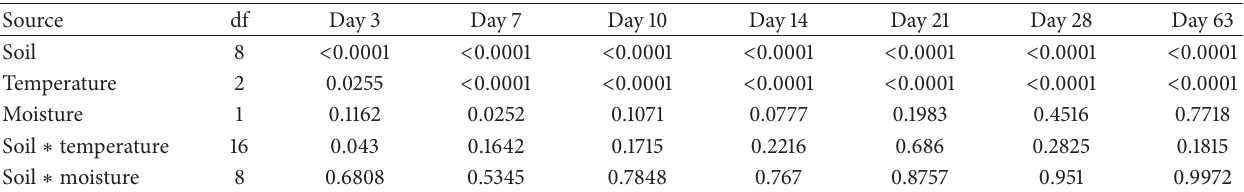
Table 3: ANOVA analysis of P . fluorescens D7rif survival by soil type, incubation temperature, and soil moisture over the 63-day incubation study ( 𝑃 < 0.05